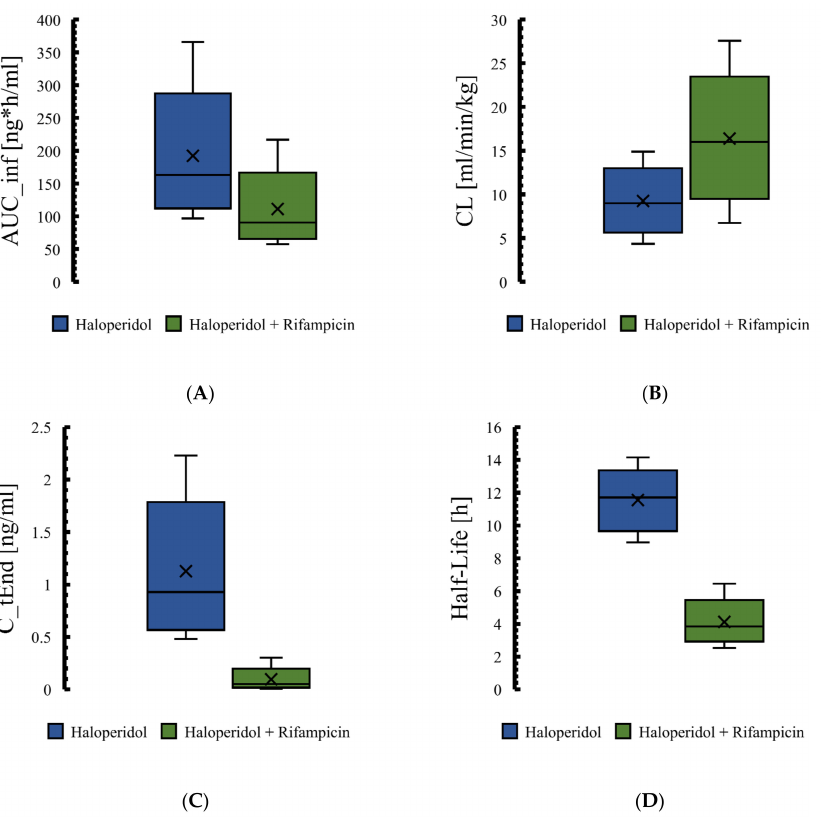
Figure 8. Plasma Box-whisker plots comparing pharmacokinetic parameters of haloperidol as a result of interaction with rifampicin. Figures ( A – D ) illustrate the effect of CYP3A4 induction by rifampicin on the haloperidol pharmacokinetic parameters. AUC: area under the curve, CL: clearance, C _tEnd : concentration at the end of the simulation.